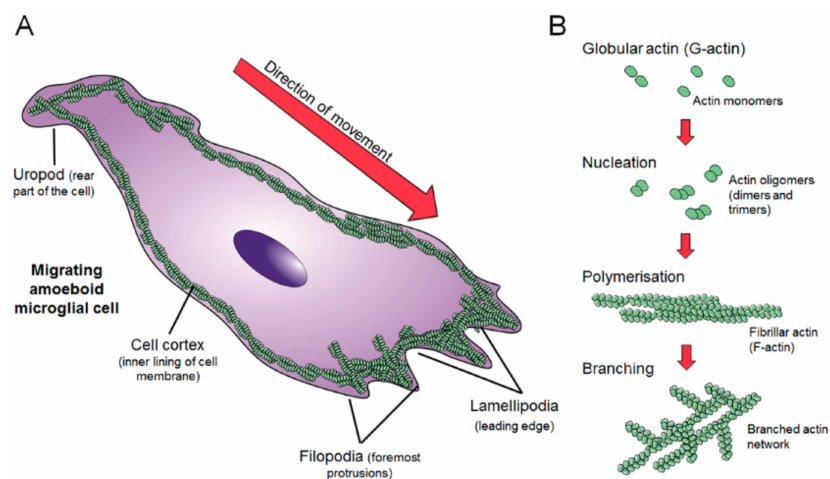
Figure 2. ( A ) Depiction of the di ff erent actin structures present in microglia: The cell cortex (covering all the inner surface of the cell), filopodai and lamellipodia (at the leading edge), and the uropod (at the rear of the cell). ( B ) Mechanism of formation of the actin network includes globular actin nucleates in the form of oligomers which further polymerize into left-handed two-chained helical filaments. Filaments additionally recruit globular actin to form branches, which extend from the mother filament at a characteristic 70 ◦ angle enabling filaments to easily connect with each other forming an intricate and highly plastic